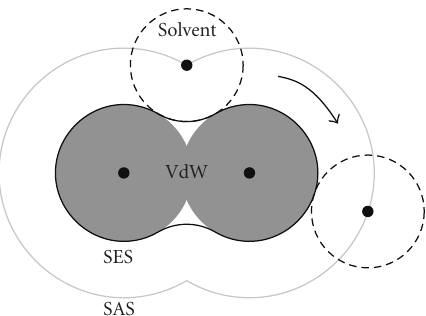
Figure 1: A cutaway view of a small molecule. The most frequent molecular surface representations are detailed. Gray discs depict the Van der Waals volumes, the gray outer line depicts the Solvent Accessible Surface (SAS) and the continuous black line depicts the Solvent Excluded Surface (SES). The SAS (resp., SES) is the limit surface for the solvent molecule center (resp., external surface). The solvent molecule is represented as a black dashed